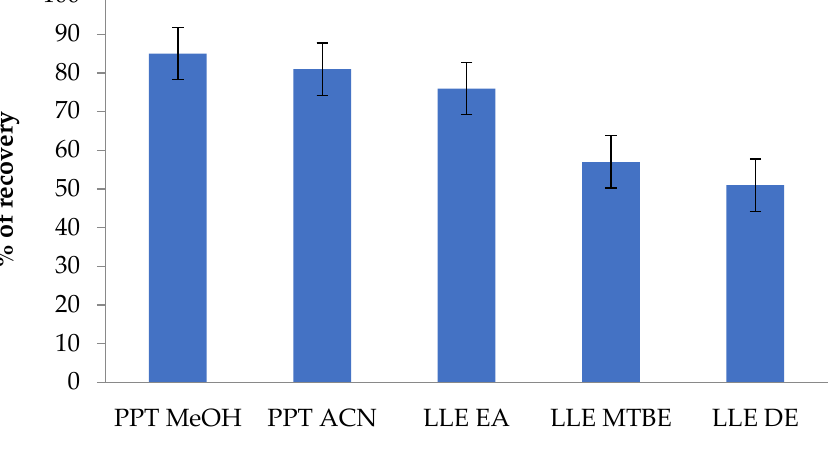
Figure 2. Extraction recovery of GAB from human plasma using different sample preparation techniques and different solvents (MeOH, methanol; CAN, acetonitrile; EA, ethyl acetate; METBE, methyl tert -butyl ether; and DE, diethyl acetate).